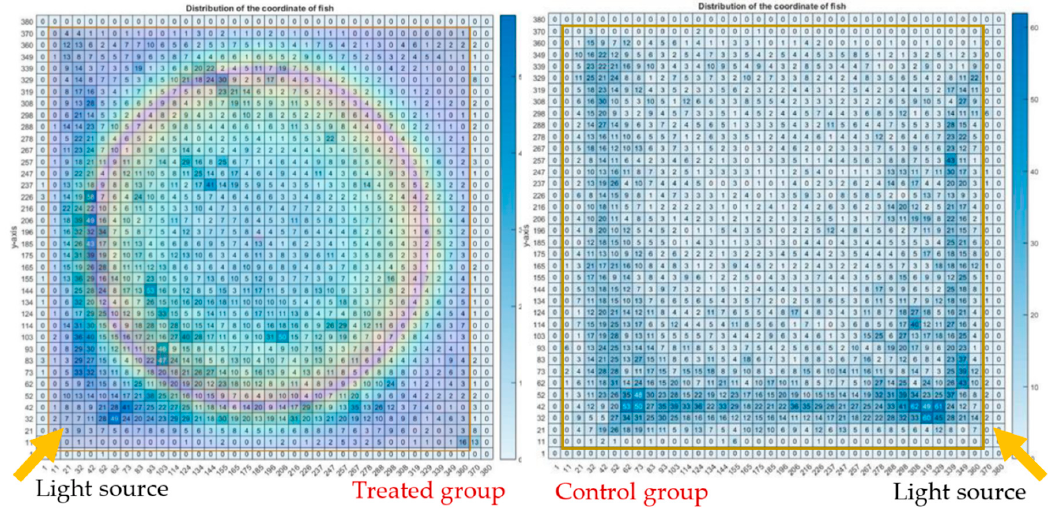
Figure 13. Heatmap chart of the coordinates of treated group with the magnet.